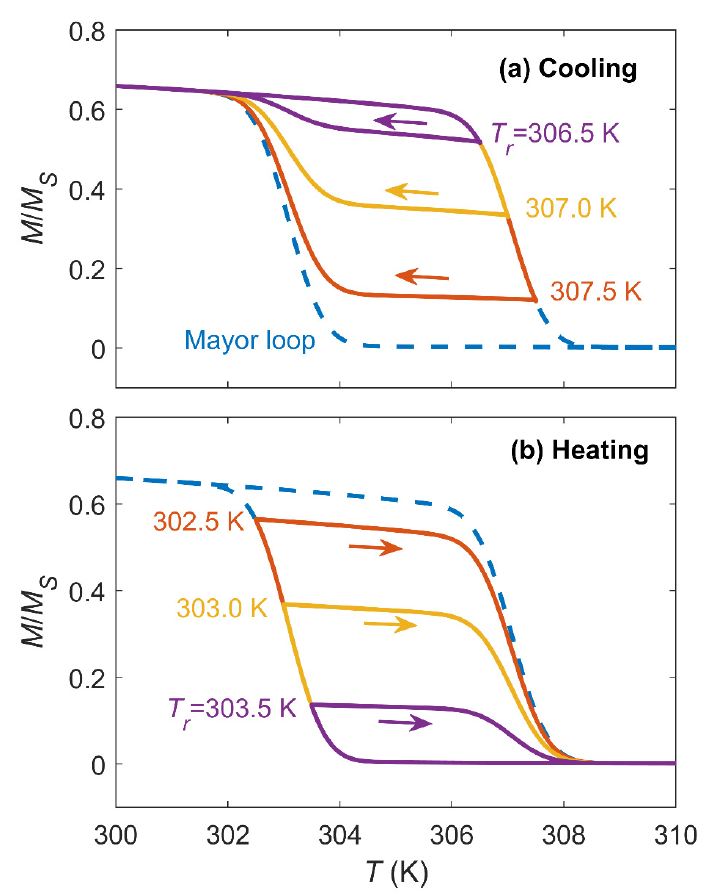
Figure 2. First order reversal magnetization curves for cooling ( a ) and heating ( b ) processes (Equations (11) and (12), respectively) from the major hysteresis loop from Figure 1.